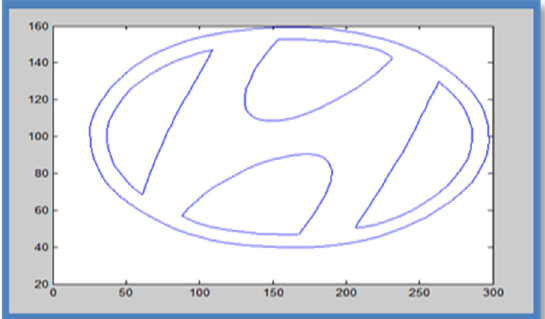
Fig. 2. Represent the higher degree Beziers’s Surface in graphical